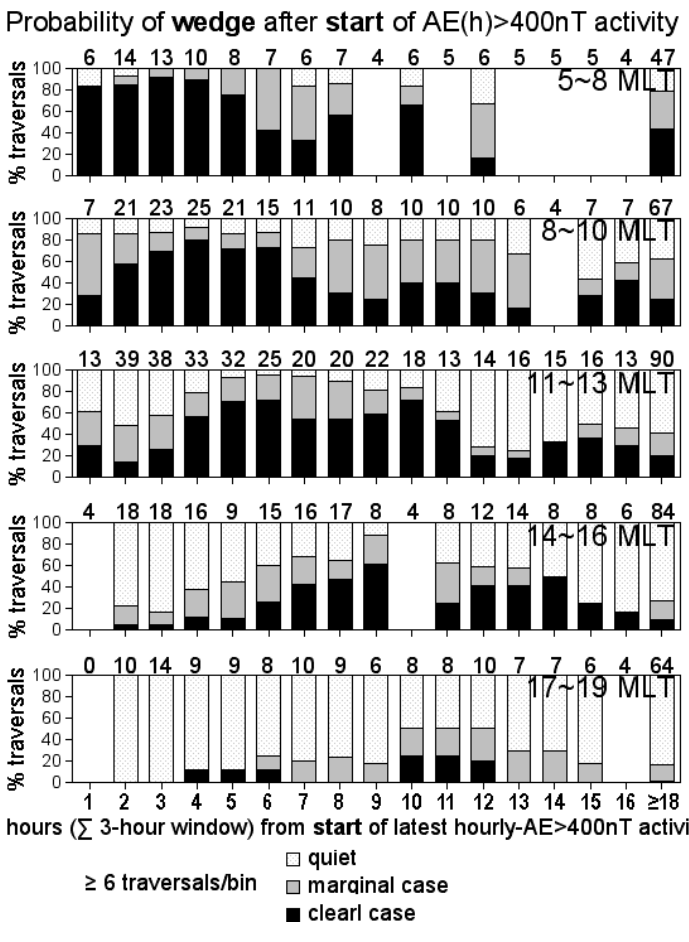
Fig. 6. The same as the previous figure, except that the time axis represents the time-lag from the start of the latest activity with hourly AE>